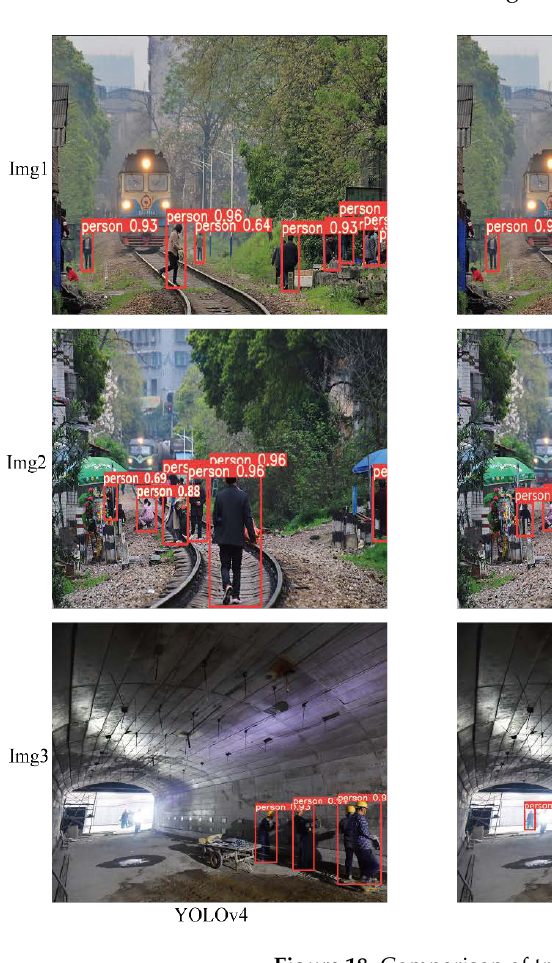
Figure 18. Comparison of training results of YOLOv5-AC and YOLOv4 and YOLOv5.